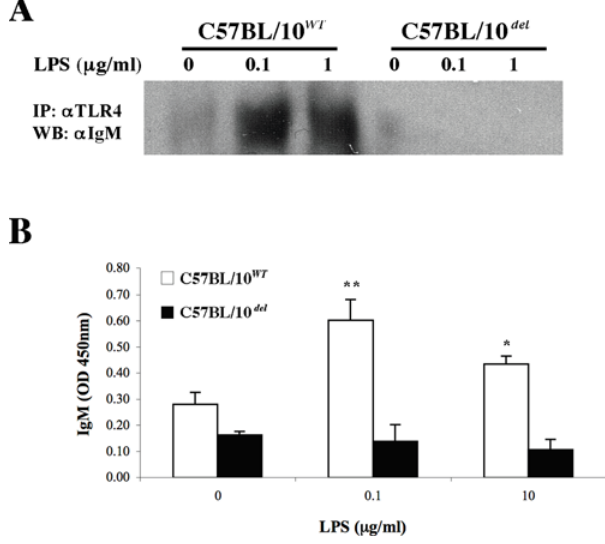
Figure 4. TLR4 and BCR interact in the membrane of LPS- activated B-cells. A. Purified B cells from TLR4 WT or TLR4 del mice were incubated for 1 hr with 0, 0.1 or 1 m g/ml of LPS, TLR4 was immunoprecipitated and bound proteins were separated by PAGE- SDS and analyzed by western blot using an IgM-specific antibody. D. Purified B cells from TLR4 WT or TLR4 del mice were incubated for 1 hr with 0, 0.1 or 1 m g/ml of LPS, TLR4 was immunoprecipitated with a specific biotinylated antibody and then captured on streptavidin- coated microplates and bound IgM was detected with a specific HRP- conjugated antibody. * P , 0.05 and ** P , 0.01 vs. control (no